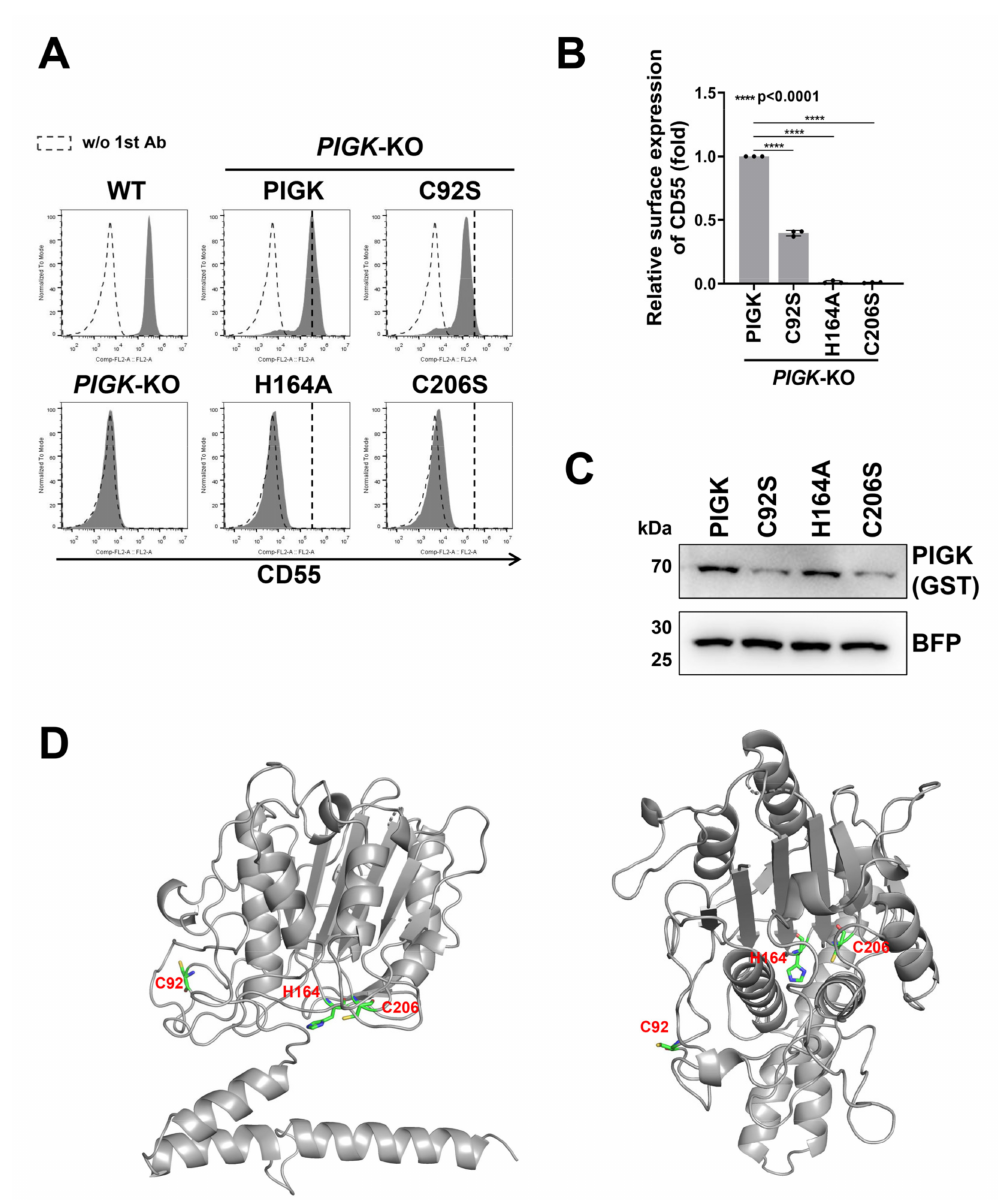
Figure 2. Functional analysis of mutant PIGK. ( A ) PIGK -KO cells were transiently transfected with both a plasmid expressing mutant PIGK and a plasmid expressing BFP. The BFP-positive cells were gated, and the surface expression of CD55 was analyzed by flow cytometry. ( B ) Mean fluorescence intensity of CD55 in PIGK -KO cells expressing wild-type PIGK-StrepII- GST was set to 1, and the relative intensities of CD55 in PIGK -KO cells expressing mutant PIGK-StrepII-GST are displayed as the mean ± SD from three independent experiments with p -values (unpaired Student’s t -test). ****, p < 0.0001. ( C ) Cell lysates prepared from the cells used in ( A ) were analyzed by western blotting. Expression of wild-type or mutant PIGK- StrepII-GST was detected. BFP was used as a control to check the transfection levels and loading. ( D ) PIGK homology model generated using the Phyre2 website. The functionally important residues (H164, C206, and C92) are depicted as green sticks, oxygen is shown in red, nitrogen is shown in blue, and sulfur is shown in